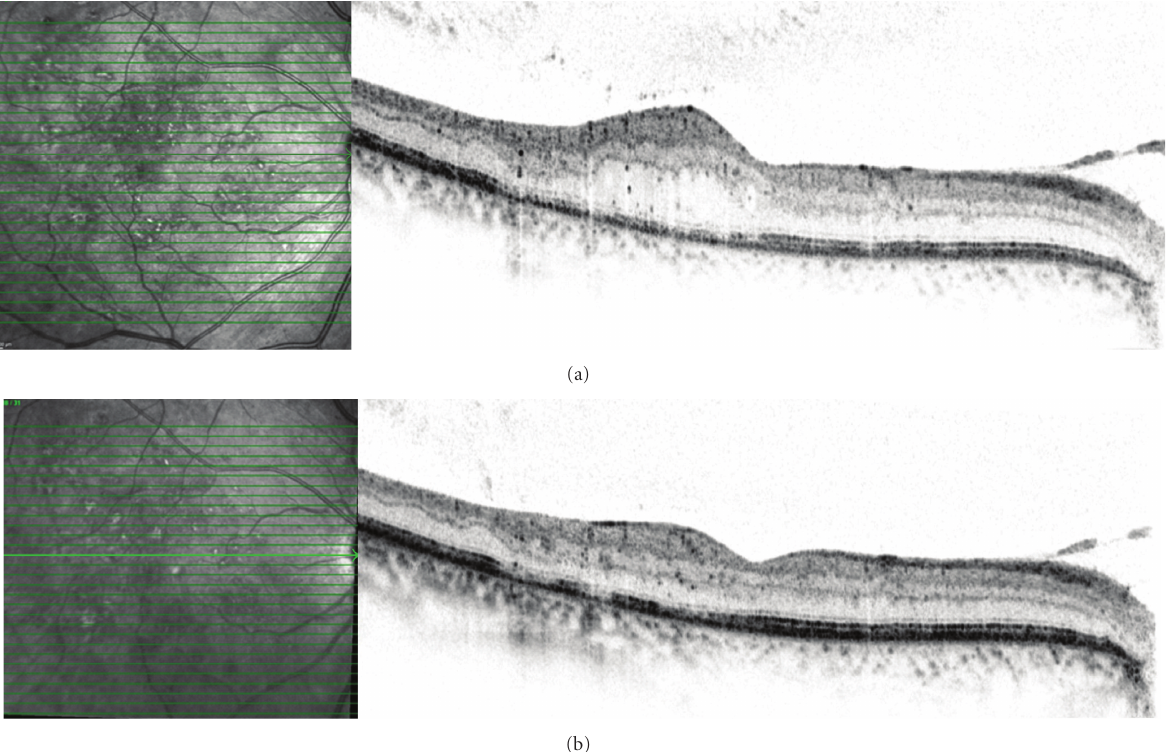
Figure 3: High-resolution OCT of the right eye of a patient with CSME. (a) shows loss of foveal contour and cystoid edema. (b) One month after intravitreal avastin injection foveal contour is restored, retinal thickening decreased significantly, and there are no cystoids spaces detected